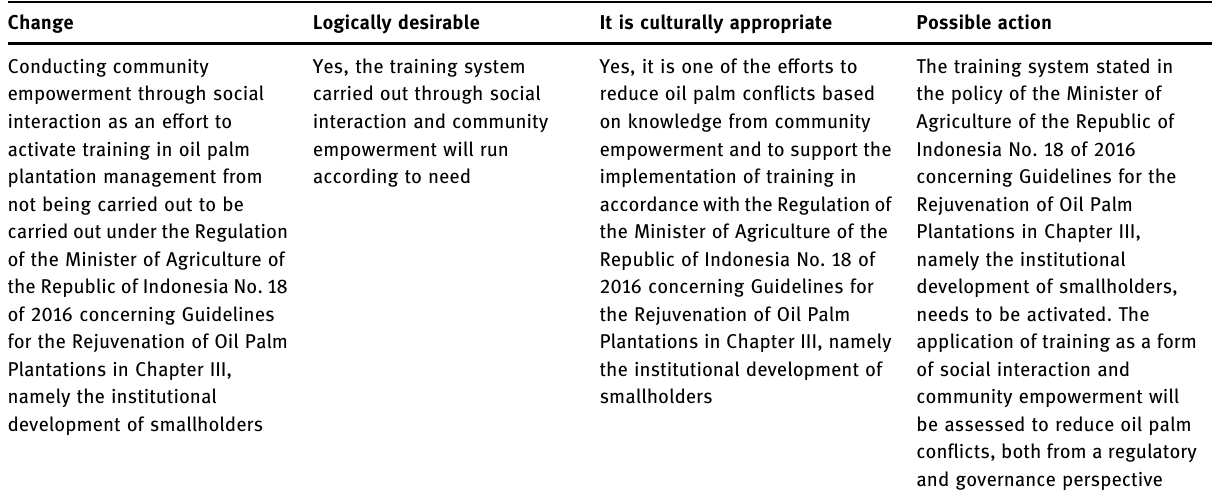
Table 5: The desired transformation